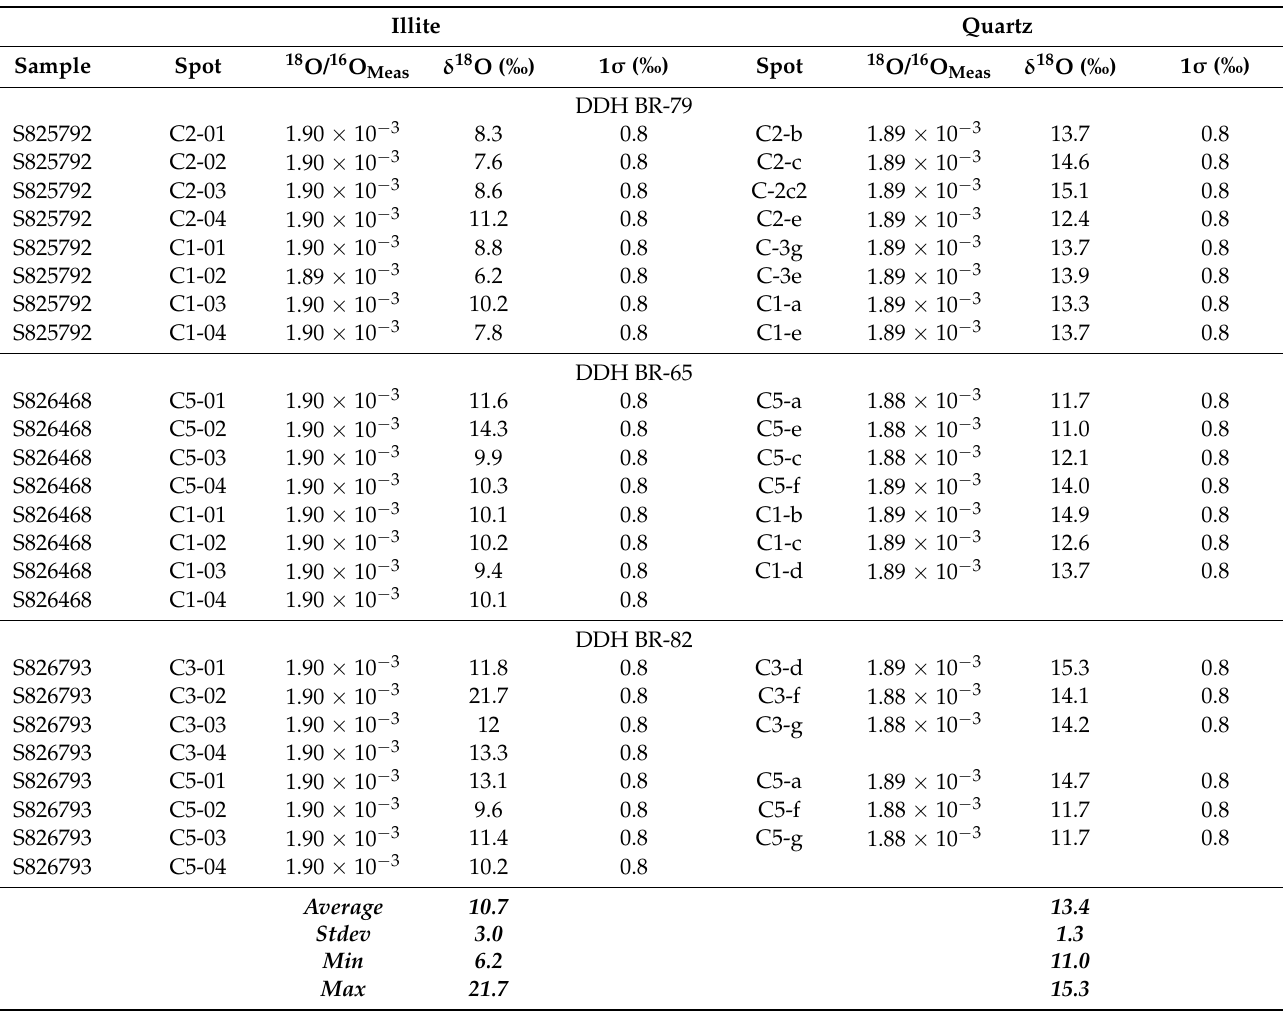
Table 4. Oxygen isotope composition of illite and quartz in felsic volcanic rocks relative to VSMOW. Abbreviations: 18 O/ 16 O 18 O/ 16 O composition, DDH—diamond drill hole, Max—maximum value, Min—minimum value, Meas —measured Stdev—standard deviation.